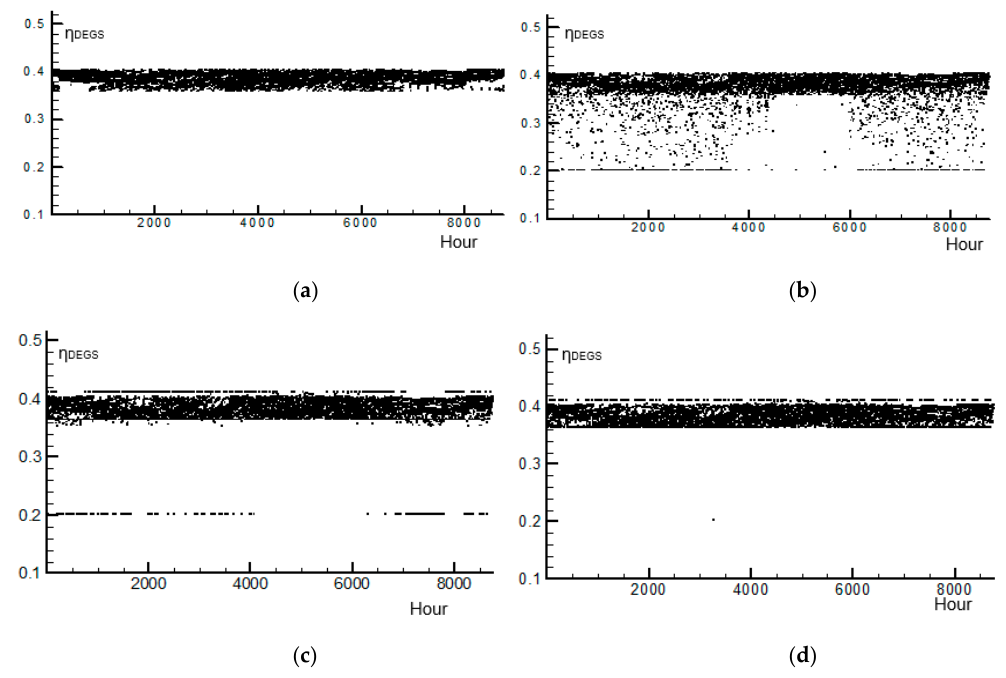
Figure 12. Hourly based electrical efficiency of the engines for a reference year in the ( a ) base case; ( b ) renewable integrated base case; ( c ) scenario 1; ( d ) scenario 2. ( b ) renewable integrated base case; ( c ) scenario 1; ( d ) scenario